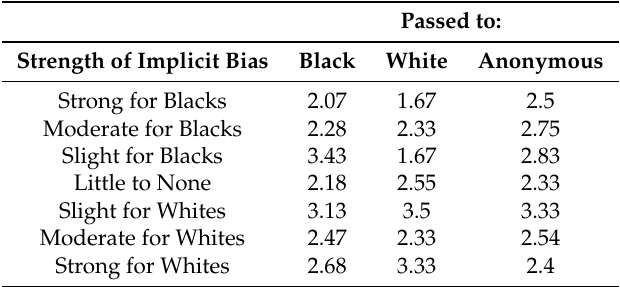
Table 4. Average amount passed by IAT score and race of